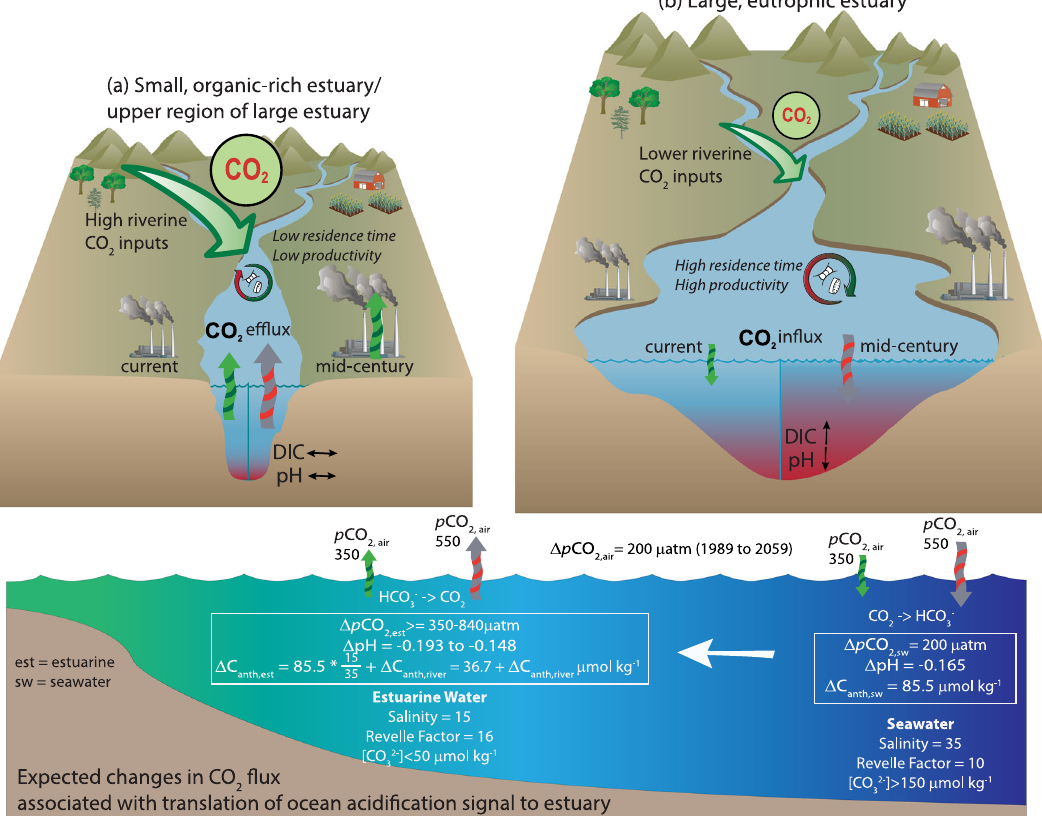
Fig. 6 Schematic of how small and large estuaries respond to higher atmospheric CO 2 levels in a changing climate. a Small estuaries with short fl ushing times will remain to be a CO 2 source to the atmosphere. High DIC shelf water imported to the estuaries is converted into CO 2 in low salinity water, raising p CO 2 inside the estuary more than that in the atmosphere and resulting in stronger emission of CO 2 in the future climate. b Large estuaries with long fl ushing times will become carbon sinks and suffer from accelerated acidi fi cation. The magnitude of air-sea CO with larger sinks if the shelf water p CO 2 stays constant and is completely decoupled to the rising atmospheric p CO 2